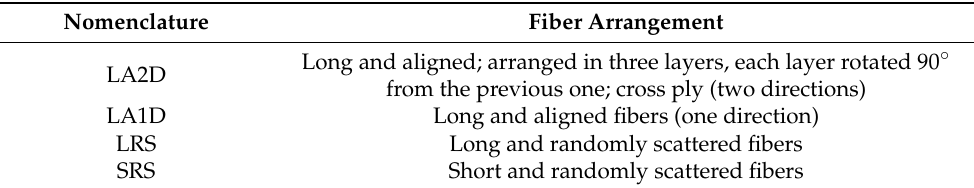
Table 1. Nomenclature and configuration of investigated